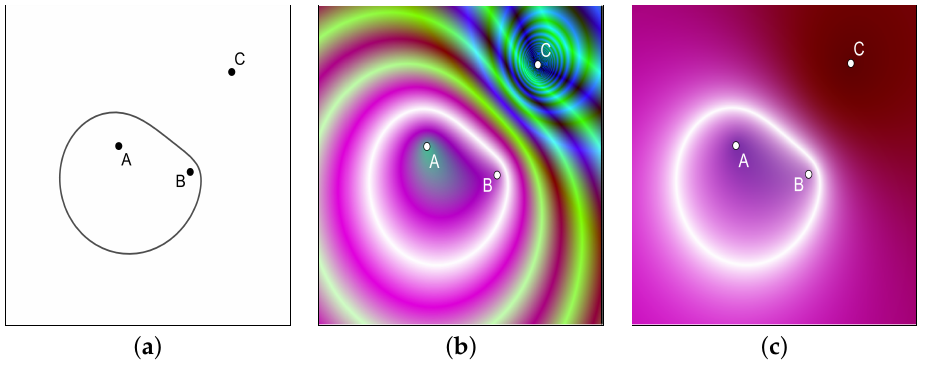
Figure 9. Locus of P such that d ( P , A ) + d ( P , B ) = d ( P , C ) , displayed ( a ) with the traditional GeoGebra tools, ( b , c ) with the dynamic color scanning